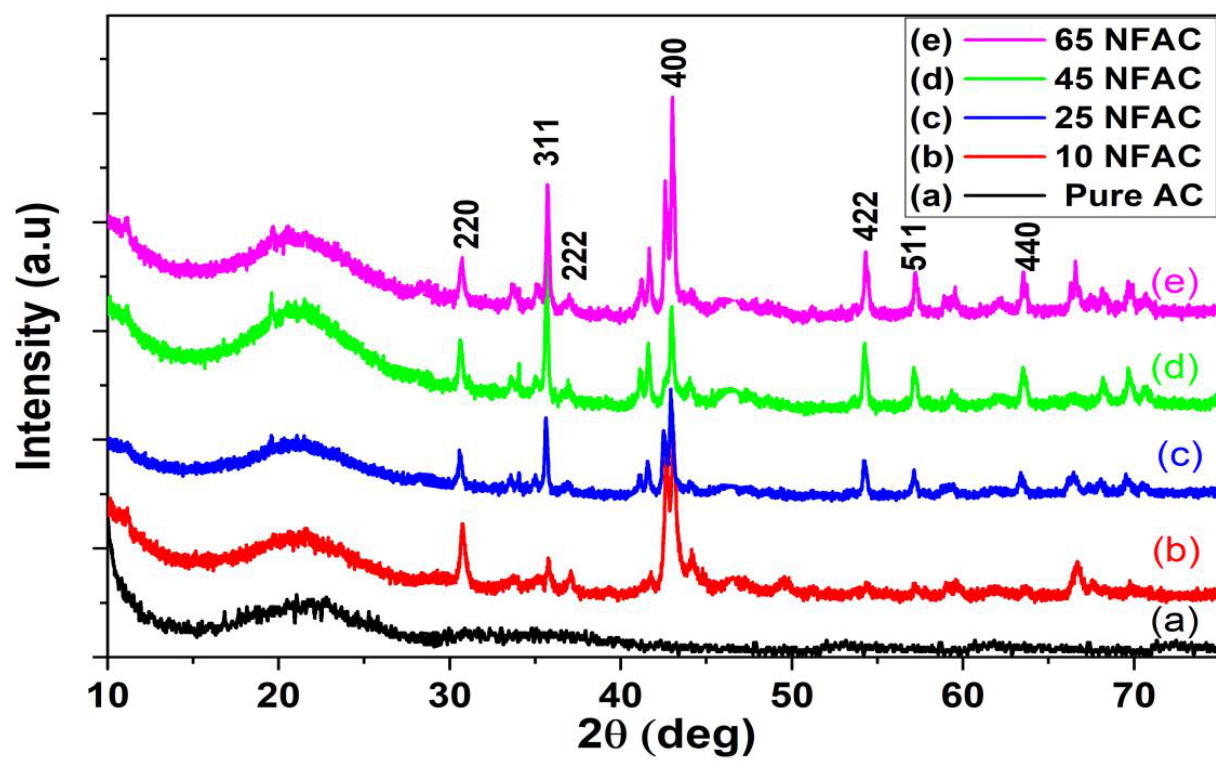
Figure 1. XRD patterns of ( a ) pure AC, ( b ) 10NFAC, ( c ) 25NFAC, ( d ) 45NFAC, and ( e ) 65 NFAC.